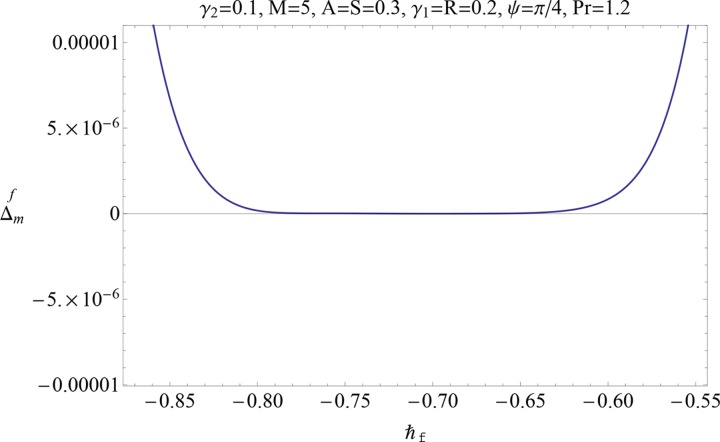
Residual error for ℏf.